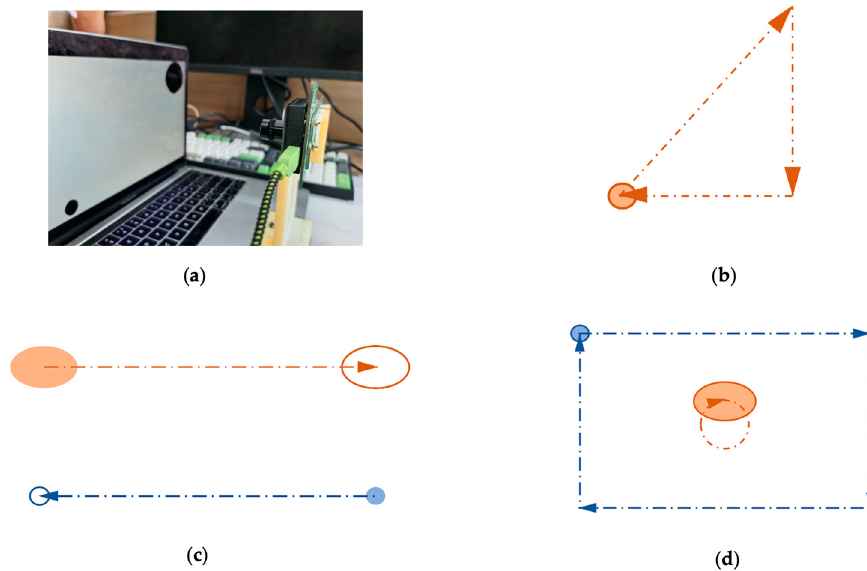
Figure 2. ( a ) Physical picture of using event camera to record the laptop screen; ( b – d ) are all animated slides of PowerPoint that make up the dataset. The solid circle represents the starting point of the object’s motion, the hollow circle represents the endpoint of the object’s movement, and the dotted line represents the trajectory of the object’s movement. Different colors represent different objects.